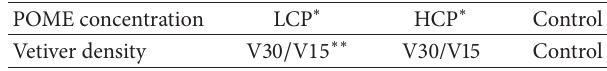
Table 1: Characteristics of POME. Table 2: Treatment